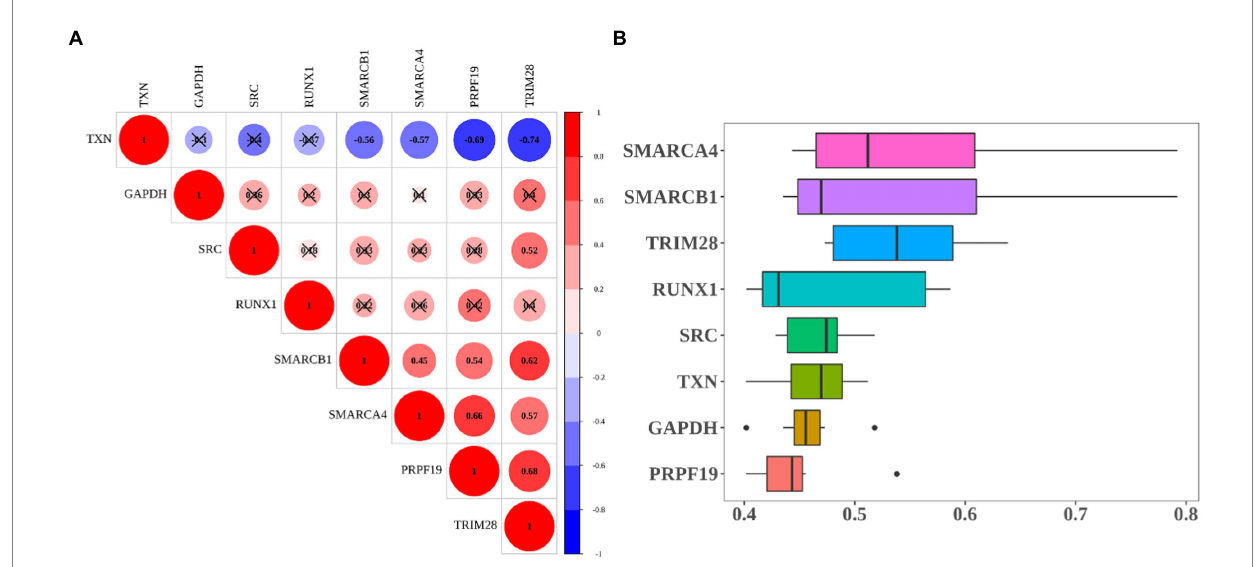
FIGURE 7 Heatmap of correlation and functional similarity among hub-genes. (A) Correlation matrix for all 8 hub genes. Some hub genes were negatively related, represented in blue, and others were positively related, represented in red. The darker the color, the higher the correlation was ( p < 0.05). (B) Functional similarity of all 8 hub genes.